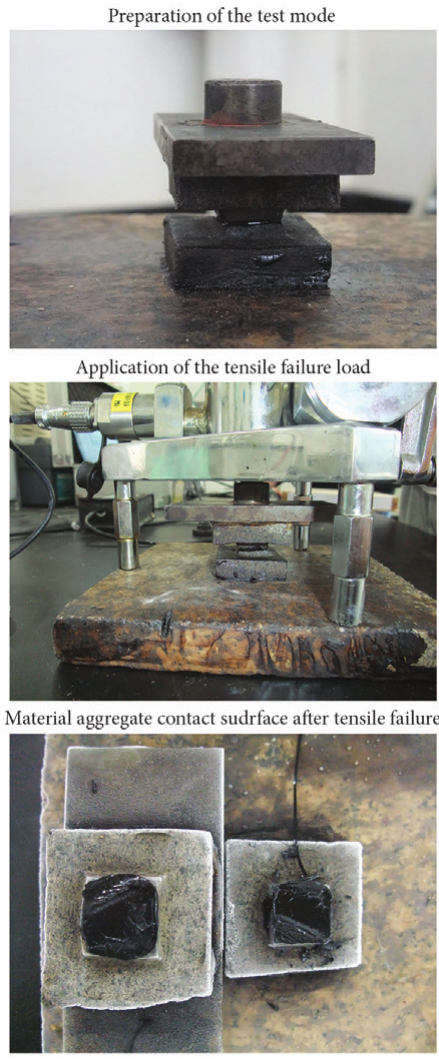
Figure 3. Quantitative test for the low-temperature cohesive strength of